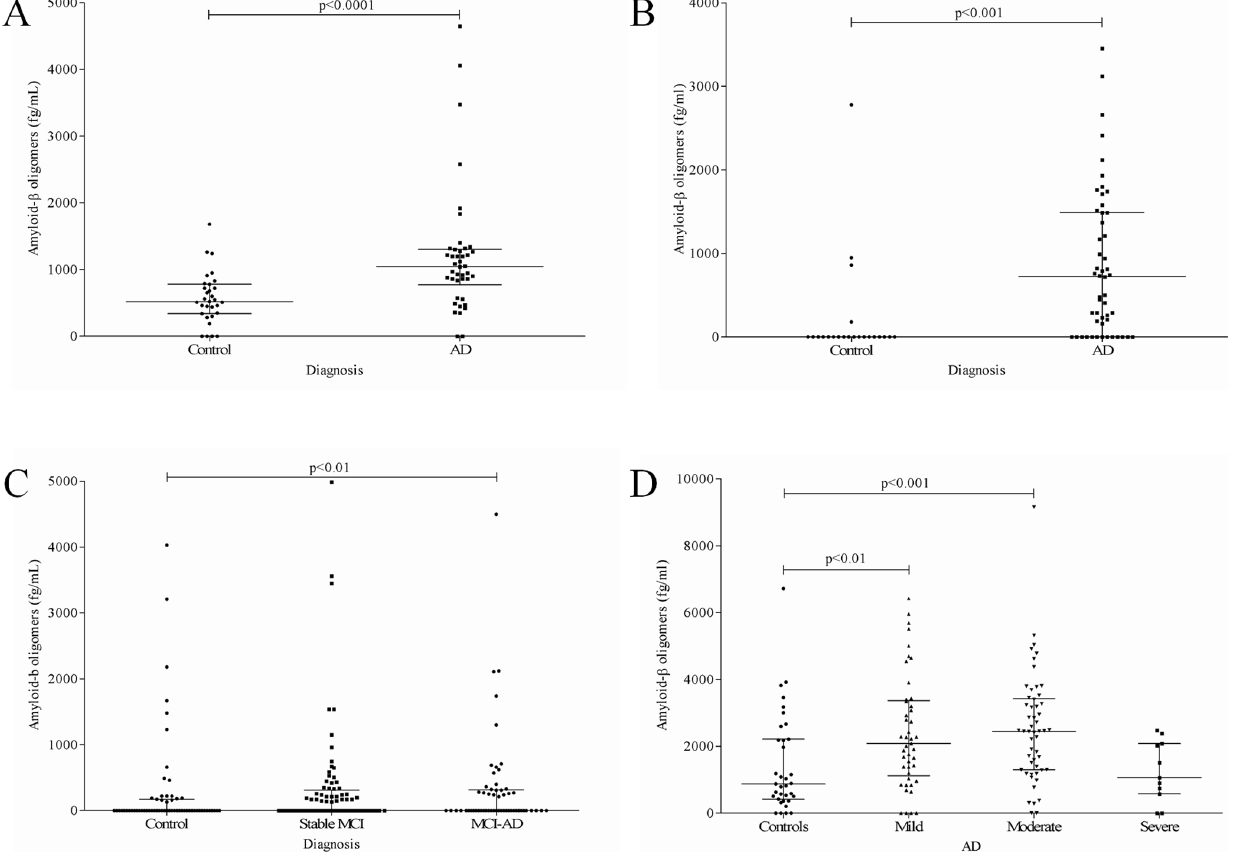
Figure 2. Cerebrospinal fluid A b oligomers in independent clinical samples. A) First AD study (Malmo¨). Increased CSF levels of A b o in the AD group (n=42) compared to the control group (n=31), p , 0.0001. Bars indicate median with interquartile range. B) Second AD study (Pitea˚ and Stockholm). Increased CSF levels of A b o in the group of patients with AD (n=51) compared to the control group (n=22), p , 0.001. Bars indicate median with interquartile range. C) MCI study. Increased CSF levels of A b o in the group of MCI patients who converted to AD during the follow-up period (n=58) as compared to the control group (n=62), p , 0.01. No significant difference in CSF A b o between stable MCI (p=0.059) and controls. Bars indicate median with interquartile range. D) Clinical study on AD with different severity of dementia. Increased CSF levels of A b o in the group of AD patients with mild (n=44, p , 0.01) and moderate (n=51, p , 0.001) dementia as compared to the control group (n=33). No significant change was found in the AD group with severe dementia (n=11) compared to the control group. Bars indicate median with interquartile